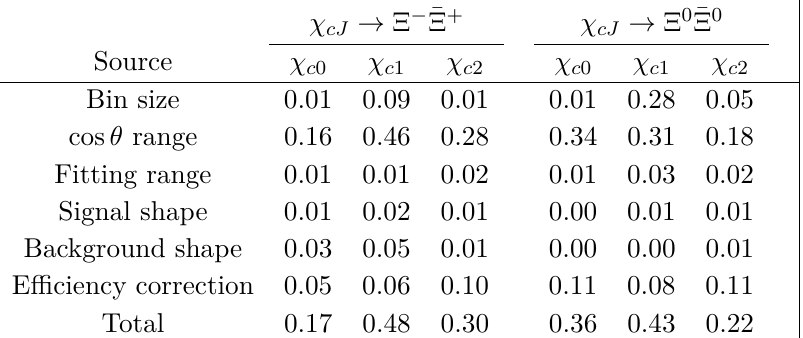
Table 4 . Systematic uncertainties on the angular-distribution measurements (absolute